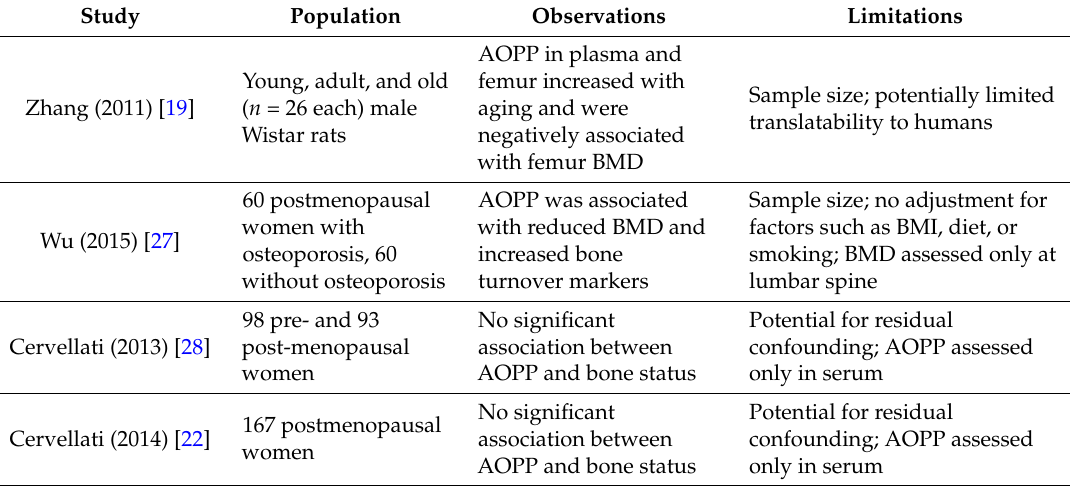
Table 1. Cross-sectional studies of AOPP and bone status in humans and